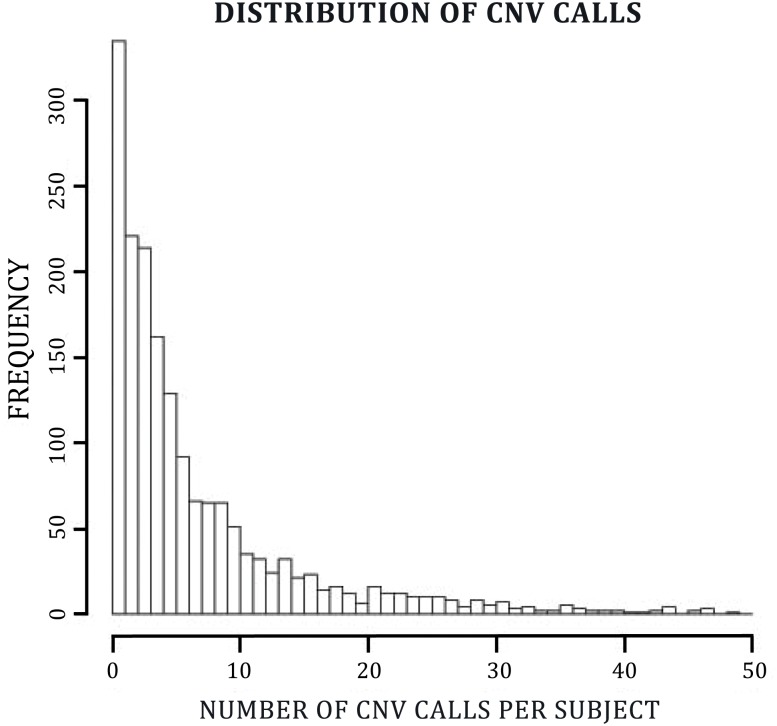
Distribution of CNV calls per subject.The figure represents a histogram with the frequency of CNV calls, with at least 30 probes, per subject.